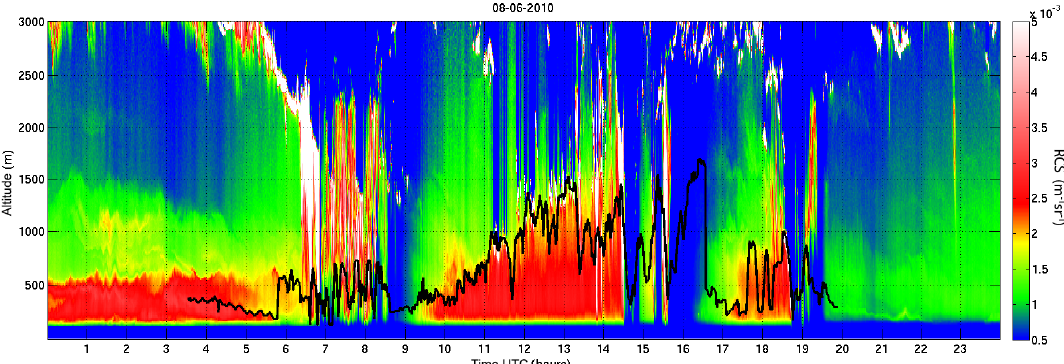
Figure 7. Lidar RCS together with pathfinder MLH estimate on 8 June 2010. A day with varying cloud types and changing precipitation rates, including some showers between 06:00 and 09:00, 15:00 and 16:00 and at 19:00UTC.